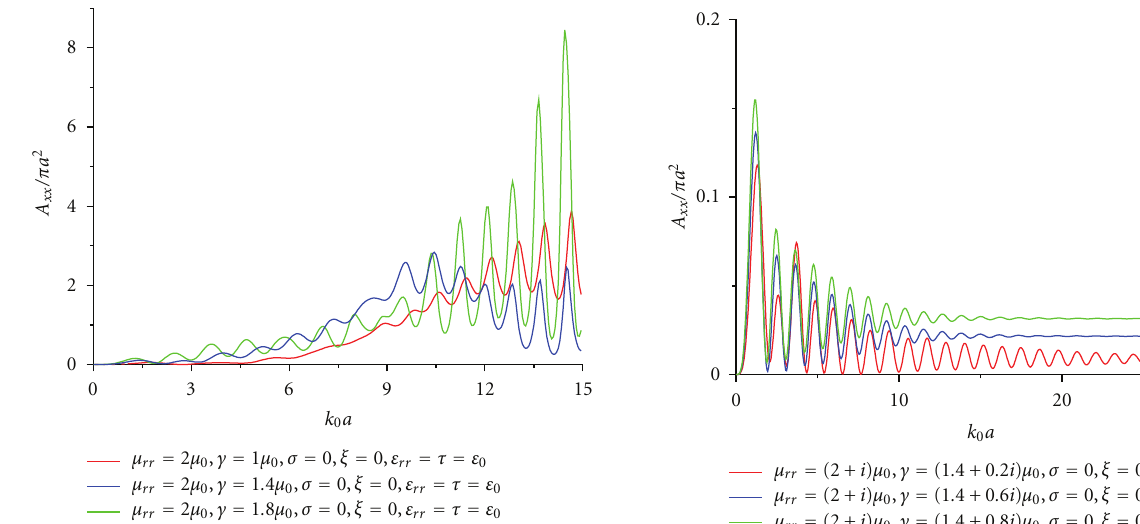
Figure 7: Normalized backscattering values versus sphere radius. Lossy positive anisotropic influence is considered. Here, the imagi- nary part for the permeability is smaller than